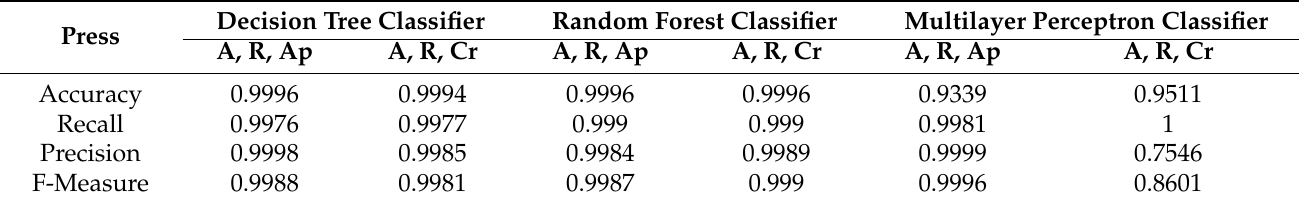
Table 6. Results from the press’ classifiers with various subsets of features used for training. With “A, R, Ap, Cr” we denote the features Active power, Reactive power, Apparent power, and Crest factor respectively.